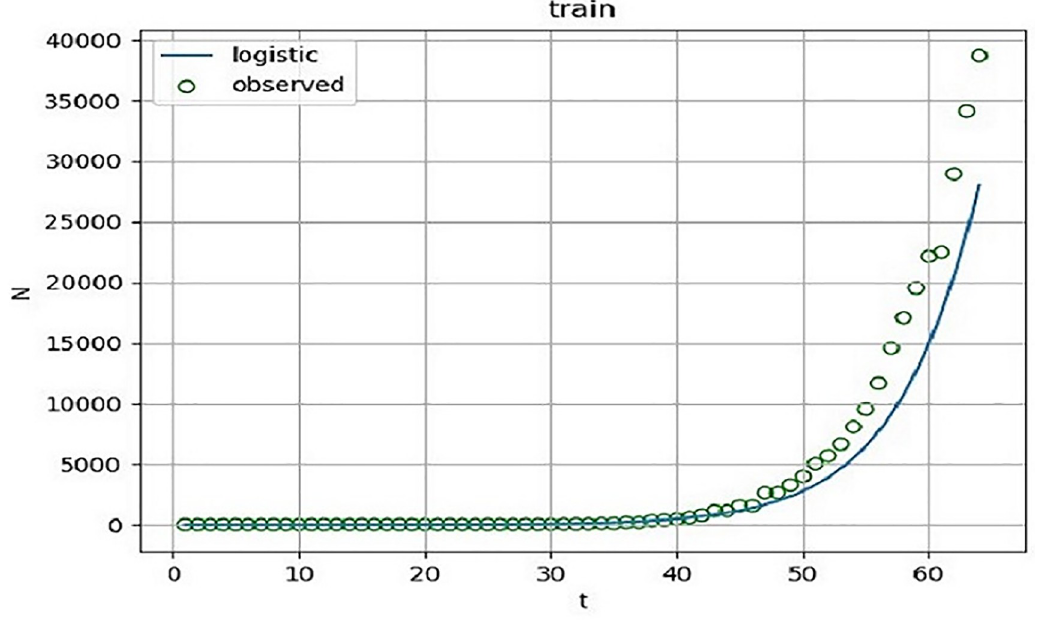
Fig 1. Logistic curve fitting diagram of cumulative confirmed cases of COVID-19. Taking the cumulative confirmed cases of COVID-19 in the UK from January 31 to April 3, 2020as a training set, and setting the upper limit M = 216526. And SPSS is used to fit the Logistic curve of the daily cumulative number of confirmed cases in this